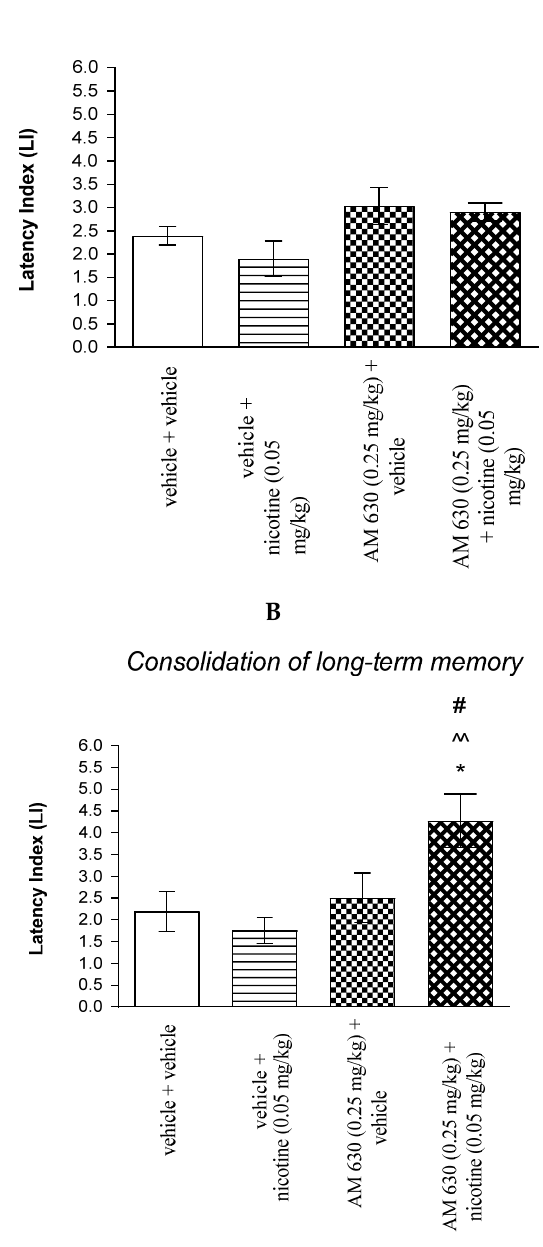
Figure 5. The influence of an acute co-administration of CB2 receptor antagonist and non-effective dose of nicotine on the cognition-related responses expressed as latency index (LI) during the acquisition ( A ) and consolidation ( B ) memory using the PA test in mice. * p < 0.05 vs. vehicle/vehicle-treated mice; ˆˆ p < 0.01 vs. vehicle/nicotine (0.05 mg/kg)-treated mice; # p < 0.05 vs. AM 630 (0.25 mg/kg)/vehicle-treated mice.